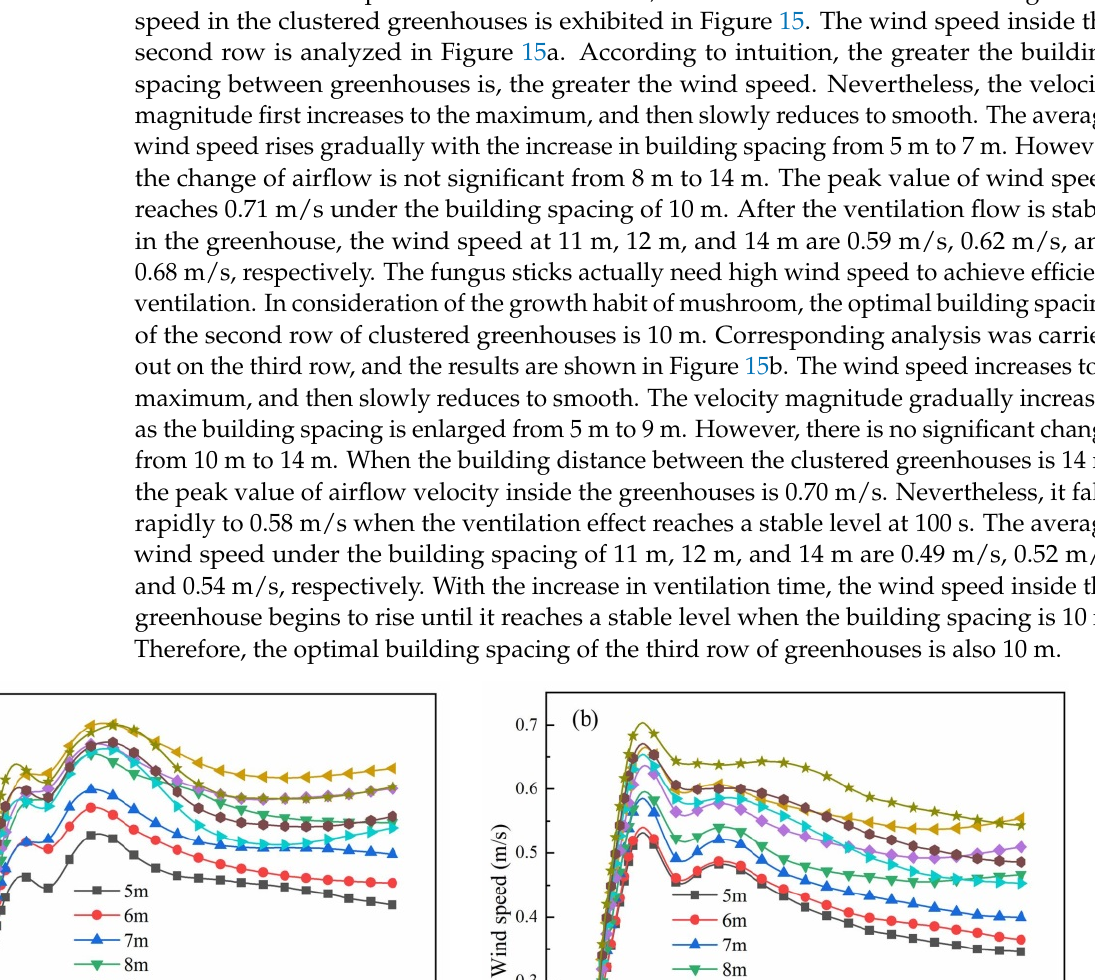
( a ) the second row; ( b ) the third row.